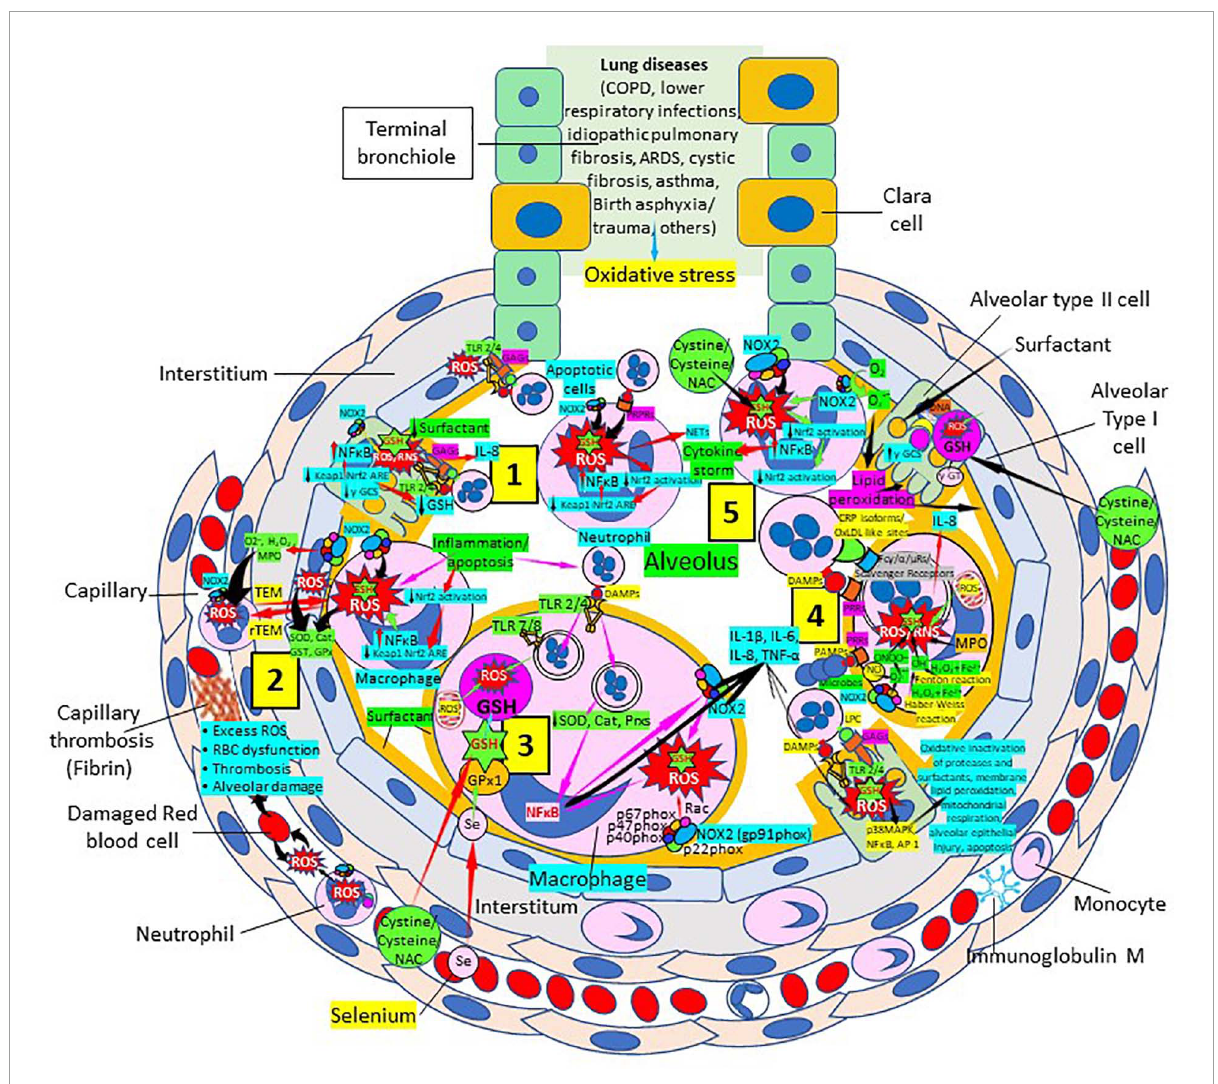
FIGURE6 Oxidative stress, reduced glutathione (GSH) and lung diseases. (1) Lung diseases affect alveolar cells increasing reactive oxygen species (ROS) production, reduce Kelch-like ECH-associated protein 1 (Keap1)-Nuclear factor erythroid 2-related factor 2 (Nrf2)-antioxidant response element (ARE) redox regulator pathway and become defective for surfactant production. Damaged/apoptotic cells cause alveolar cell activation of nuclear factor (NF)- κ B and release cytokines like interleukin (IL)-8. Alveolar type I cells augment ROS production via toll-like receptors (TLRs) 1 and 2. Inflammation enhances neutrophil extracellular trap (NET) release and increases ROS production. (2) Inflammation associated to lung diseases augments macrophage’s ROS production, inhibiting Nrf2 activation and enhancing NF- κ B upregulation. ROS are counterbalanced by enzymes like superoxide dismutase (SOD), catalase (Cat), glutathione S-transferase (GST), and glutathione peroxidase (GPx) to protect cells from oxidative damage caused by nicotinamide adenine-dinucleotide phosphate (NADPH) oxidase 2 (NOX2), superoxide (O 2 − ), hydrogen peroxide (H 2 O 2 ), and myeloperoxidase (MPO). Capillary neutrophils migrate to and from alveoli by trans- endothelial (TEM) and reverse transmigration (rTEM), respectively. Inflammation can cause excessive ROS production in capillaries, red blood cell (RBC) dysfunction, thrombosis and